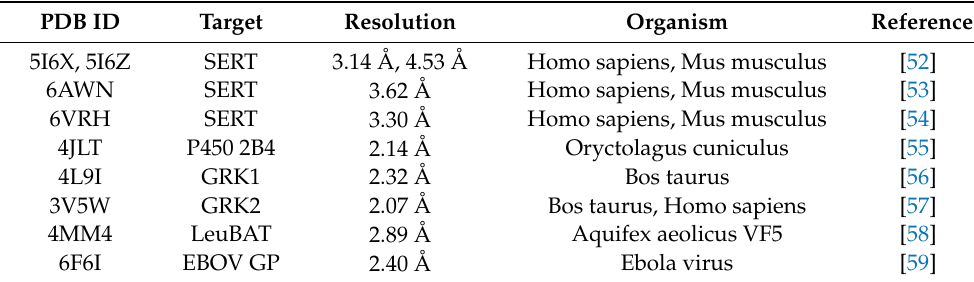
Table 1. The list of the crystal structure of target bounded